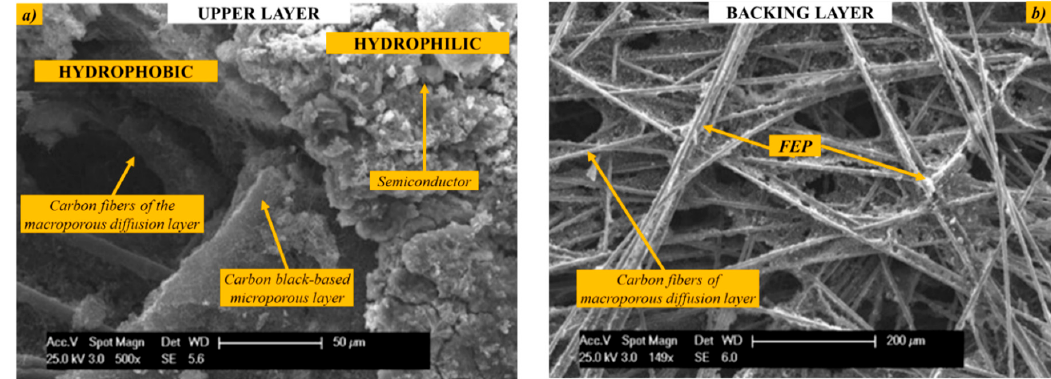
Figure 5. SEM images of the CuO semiconductor on a Sigracet 35BC ® gas diffusion layer containing 7% FEP: upper layer ( a ), backing layer ( b ).